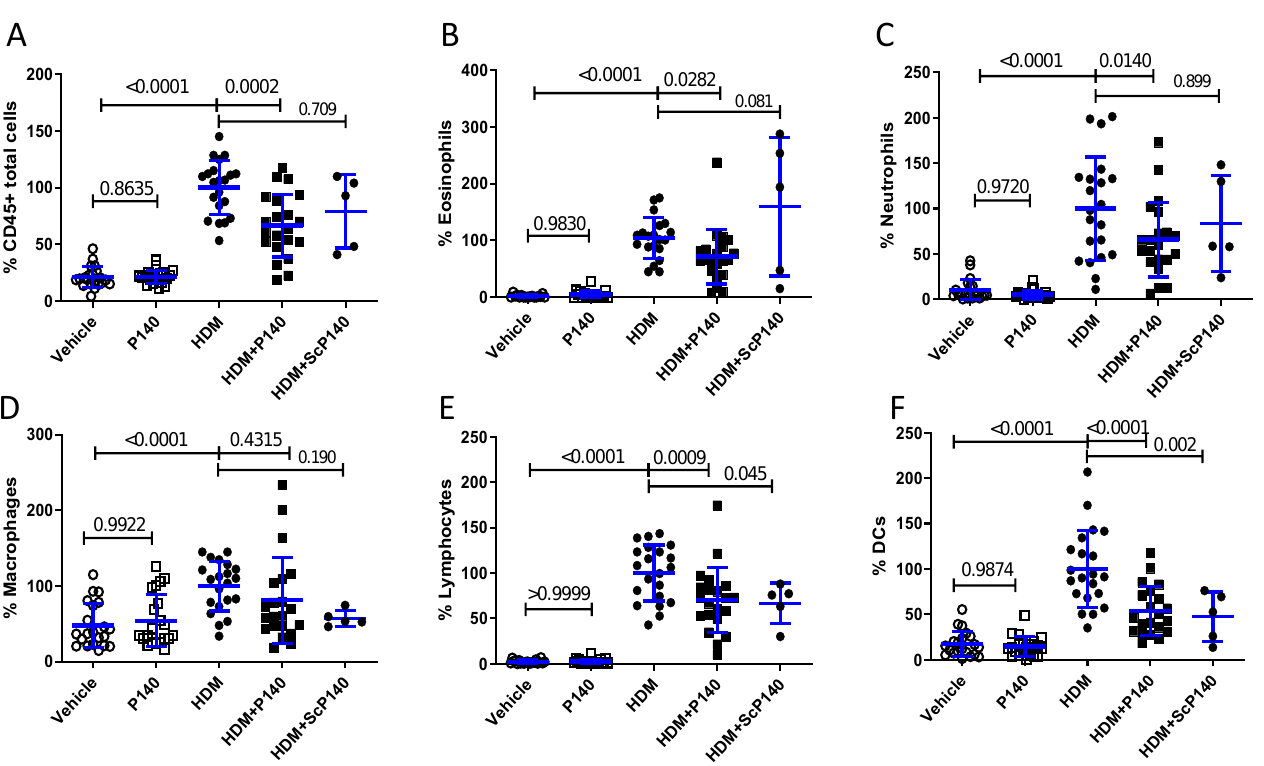
Figure 3. Effect of the P140 peptide on the cell content of BALFs collected from HDM-sensitized and challenged mice. 9-week-old female BALB/c mice were sensitized and challenged intranasally as indicated in Figure 2A. They receive vehicle, P140 or ScP140 intravenously at day 22, and BALFs were collected at day 31. The cell content of BALFs was studied by flow cytometry. ( A – F ) show the percentage of total CD45 + immune cells, eosinophils, neutrophils, macrophages, lymphocytes and DCs, respectively, expressed with regard to the average number of cells measured in the BALs of HDM-induced mice taken as 100%. The data are presented as the mean ± SEM ( n = 5 or 21 mice per group from four independent experiments).